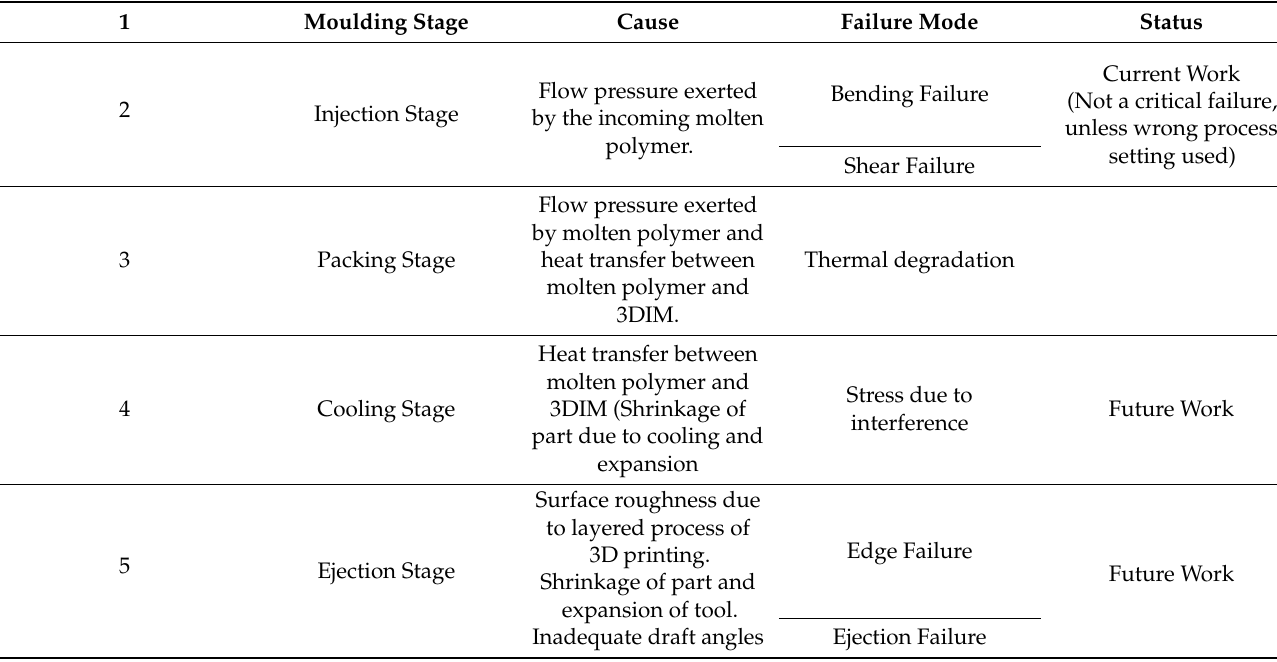
Table 10. Classification of raised feature failure in